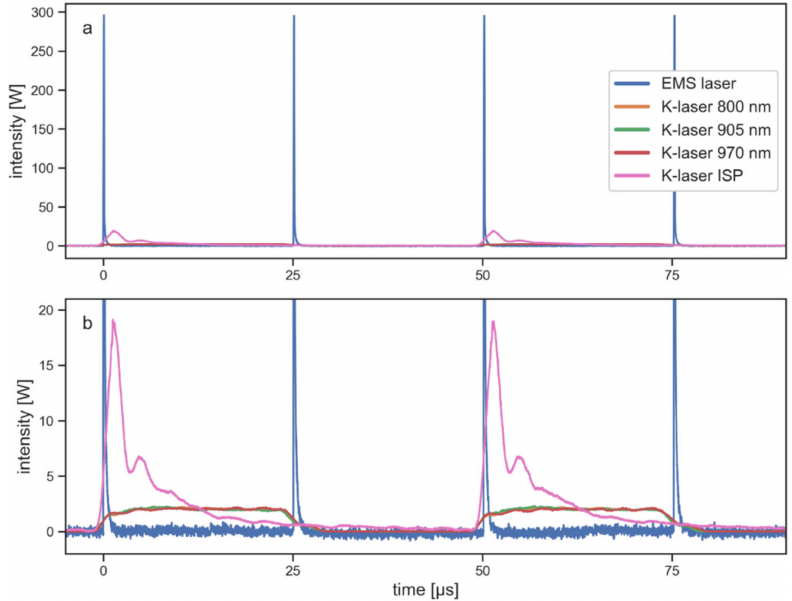
Figure 3. Light intensity of the two laser therapy devices investigated in the present study in time recorded with the fast photodetector sensor (FPD). The same signals are plotted showing the full range ( a ) and using a smaller range to better depict the signals of the K-laser ( b ). Since the FPD is recording relative measurements, intensity values were scaled to fit the power that was used during the penetration depth experiments. Peak power was 300 W for the EMS laser, 20 W for the K-laser in ISP mode and 2 W for the individual diodes of the K-laser. Average powers of all laser beams were set to 1–1.2 W. Repetition rates were set to the maximum of each device: 40 kHz for the EMS laser and 20 kHz for the K-laser. A moving-average filter was applied to the signals; the observed differences in noise levels were mainly introduced by